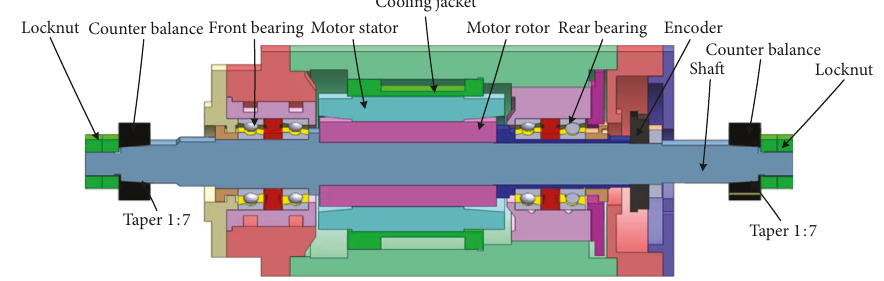
Figure 1: High-speed spindle model.